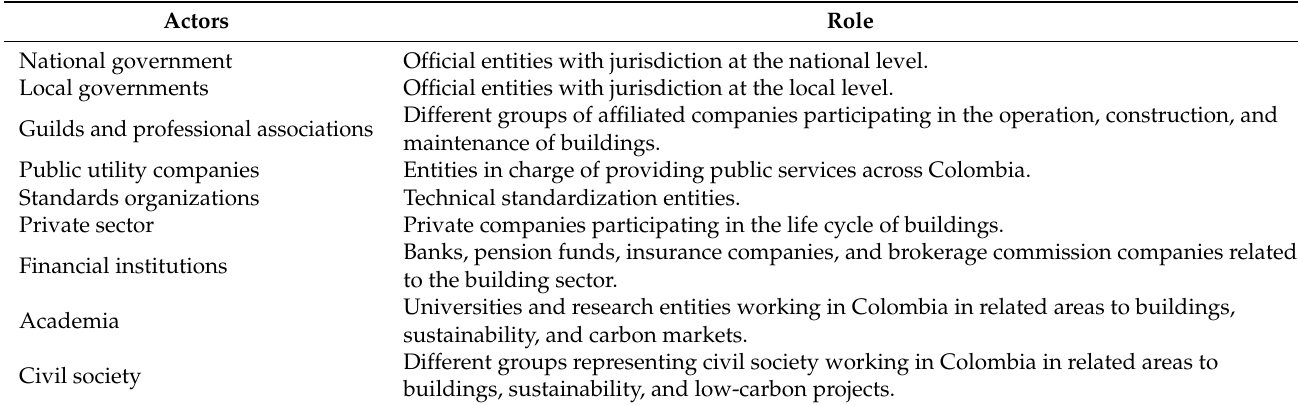
Table 4. Actor categories identified by the workshop